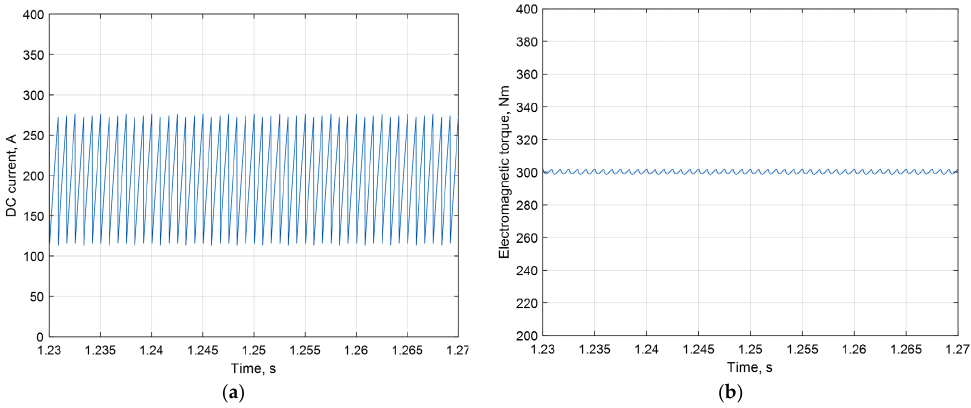
Figure 19. Stator currents ( a ), rotor currents ( b ) of 12PIM in steady-state mode: ph. A—blue, ph. B—red, ph. C—yellow.